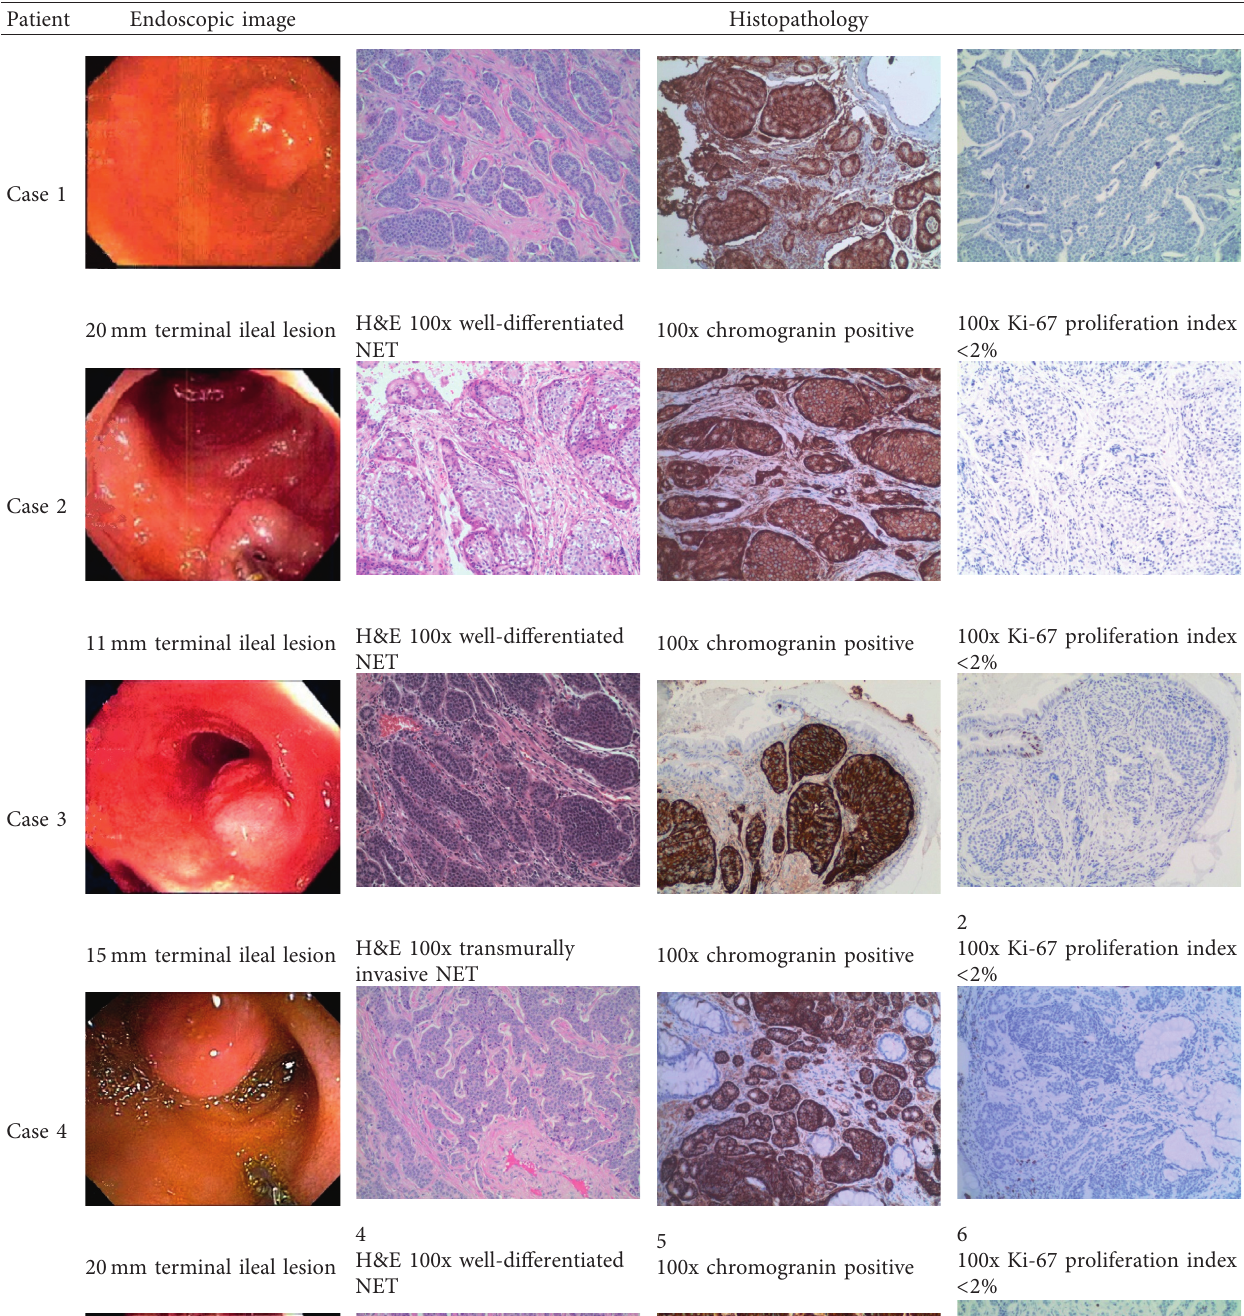
Table 2: Colonoscopy and histopathology